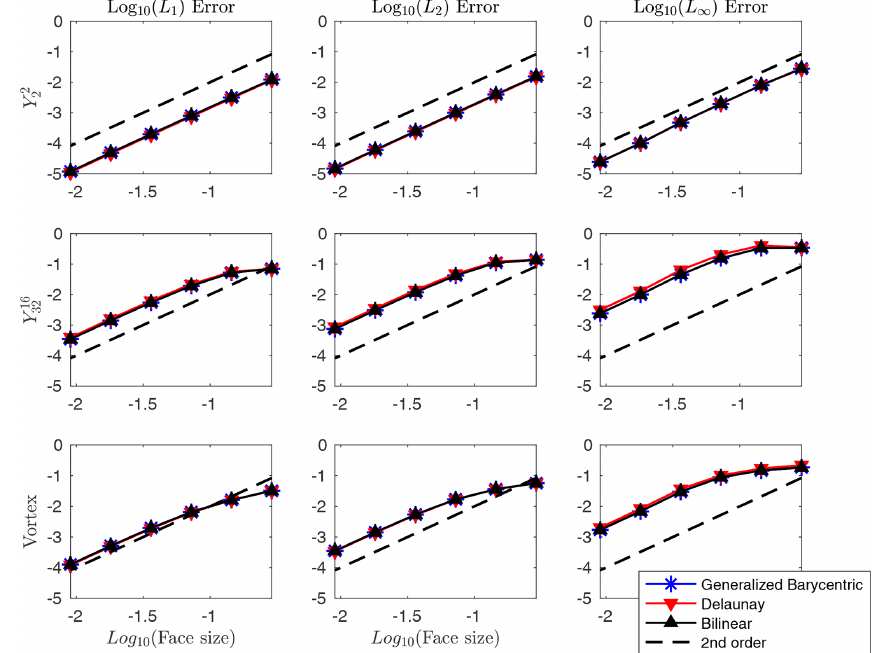
Figure 12. Convergence results for several integrated monotone remapping schemes for a fixed latitude–longitude target mesh and cubed sphere source